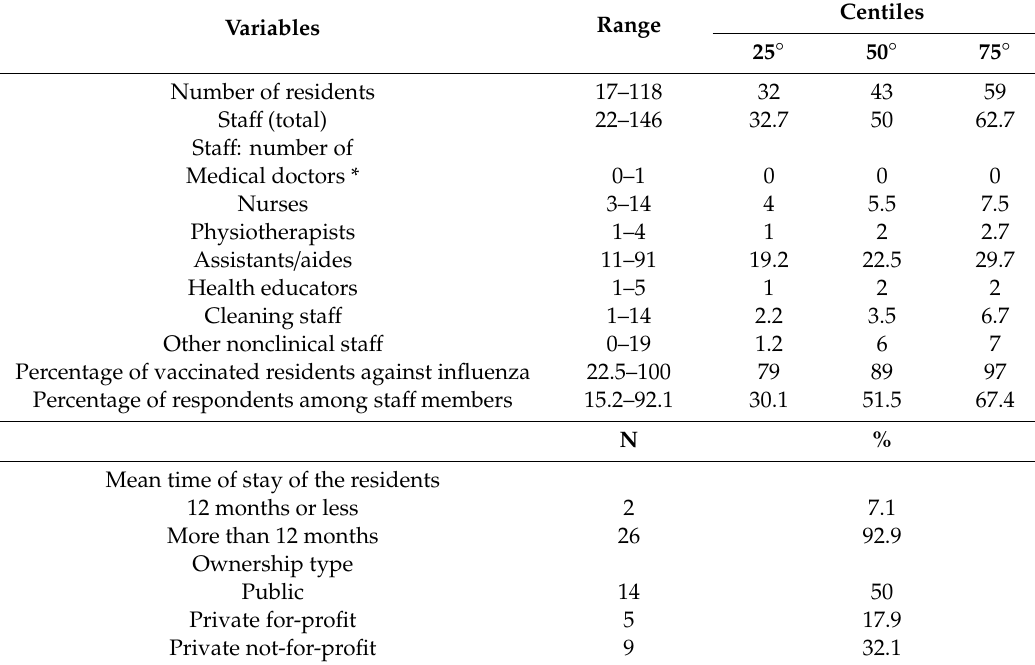
Table 1. Characteristics of the nursing homes (N =